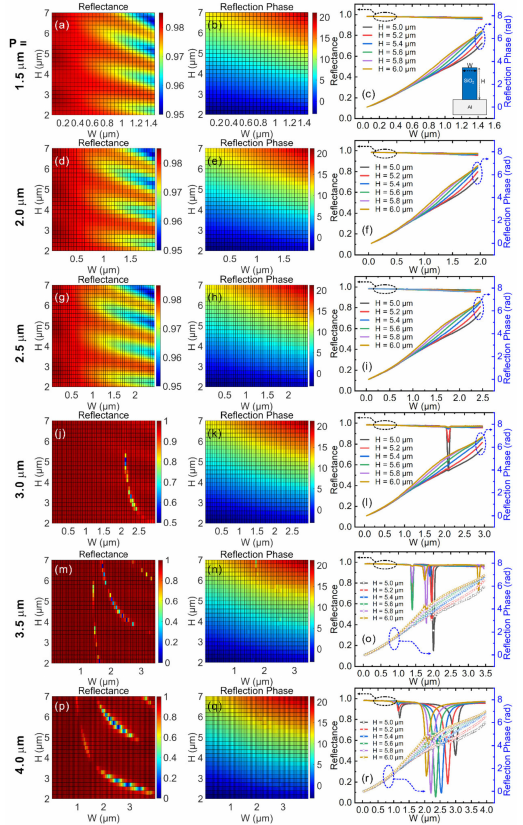
Figure 2. Simulation data for parameter sweep. The period (P) of meta-atoms changed from 1.5 to 4.0 µ m in steps of 0.5 µ m. For each period, the width (W) of SiO 2 stripes changed from 0.05 µ m to P—0.05 µ m in steps of 0.05 µ m, and height (H) of SiO 2 stripes changed from 2.0 µ m to 7.0 µ m in steps of 0.2 µ m. Left column ( a , d , g , j , m , p ): color map of reflectance with various W and H